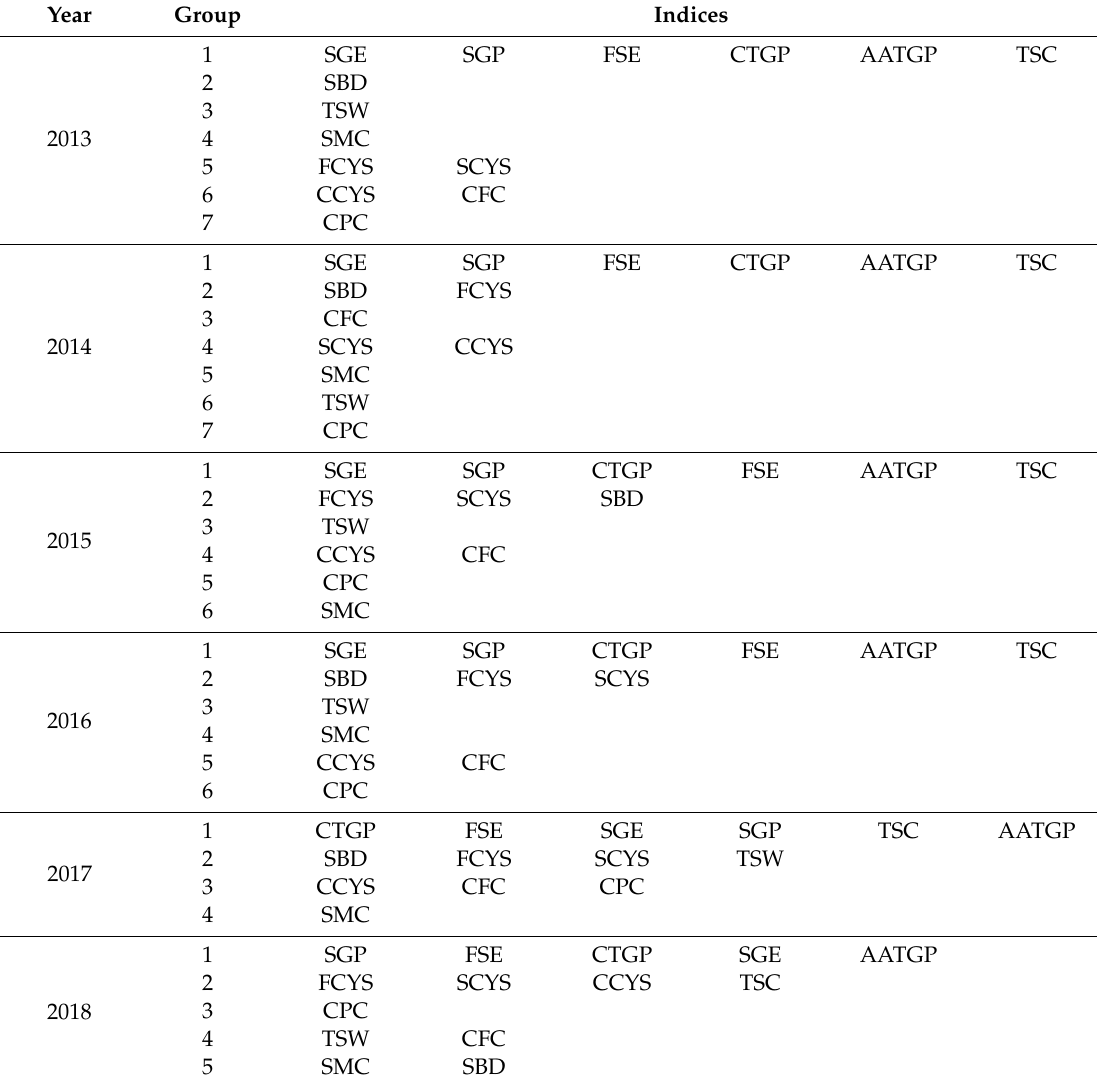
Table 3. Cluster analysis of maize seed quality indices from 2013 to